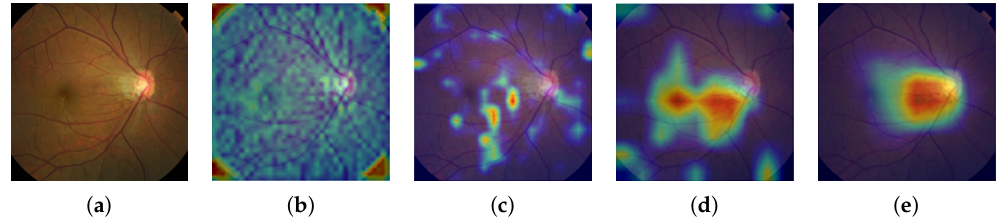
Figure 5. Dataset-C: Visualization of intermediate layers, at the end of each ResNet block, of ResNet-152-M. The leftmost image is the input image, and the rightmost image is the last convolutional layer of the network. ( a ) An original funuds image inpu; ( b ) The 1st ResNet block output; ( c ) The 2nd ResNet block output; ( d ) The 3rd ResNet block output; ( e ) The final output.